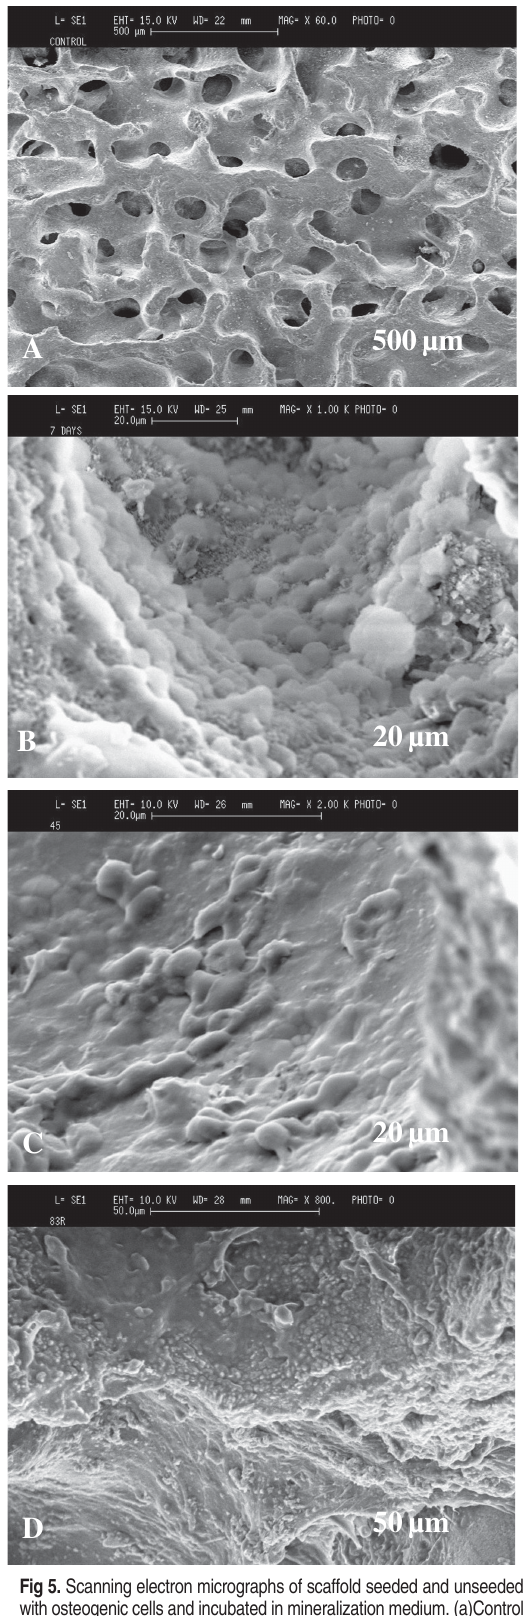
Fig 5. Scanning electron micrographs of scaffold seeded and unseeded with osteogenic cells and incubated in mineralization medium. (a)Control unseeded coral scaffold. (b) Seeded scaffold after 1 week of incubation. (C, D Seeded scaffold after 4 weeks of